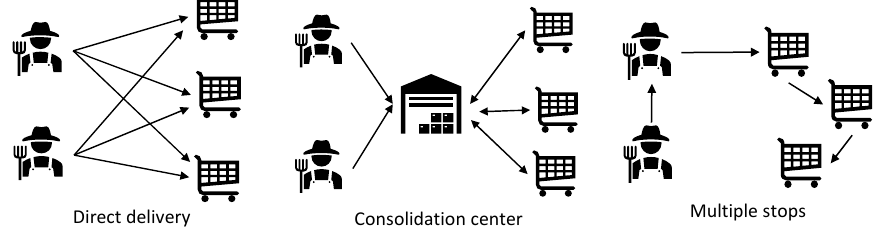
Figure 1. The principal merchandise distribution strategies between suppliers and customers. Source: own elaboration.